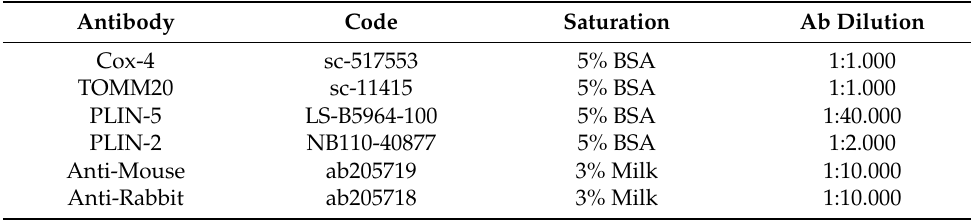
Table 3. Antibodies adopted in the